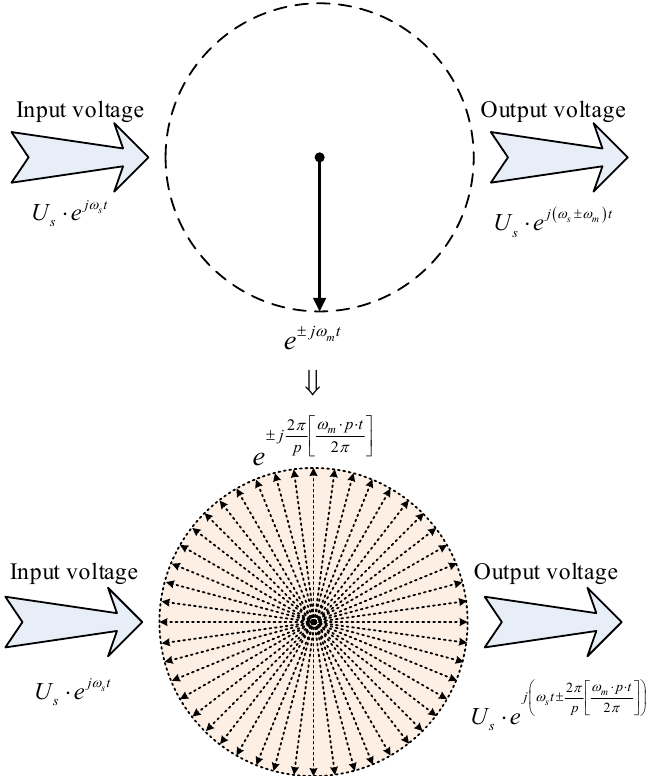
Figure 3. The general discrete reference vector projection concept: U s —voltage amplitude, ω s and ω m pulsations, p a number of discrete voltage vectors [7].